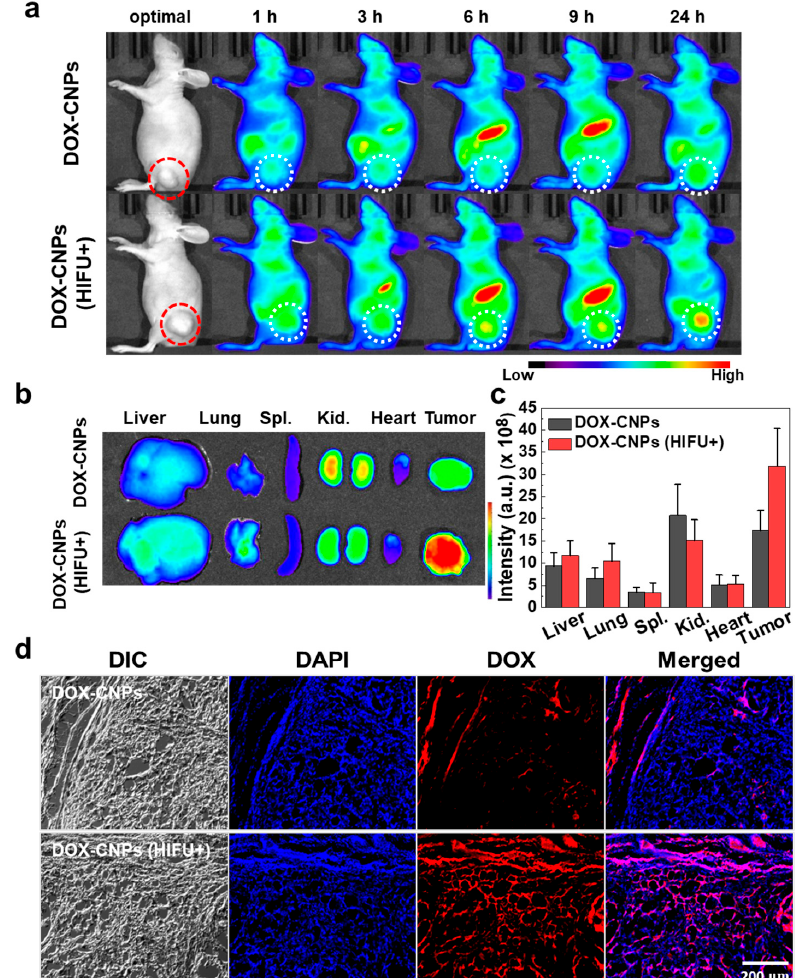
Figure 4. In vivo near-infrared fluorescence (NIRF) imaging of Cy5.5-labeled DOX-CNPs in ECM-rich A549 tumor animal model. ( a ) Biodistribution of Cy5.5-labeled DOX-CNPs without and with HIFU